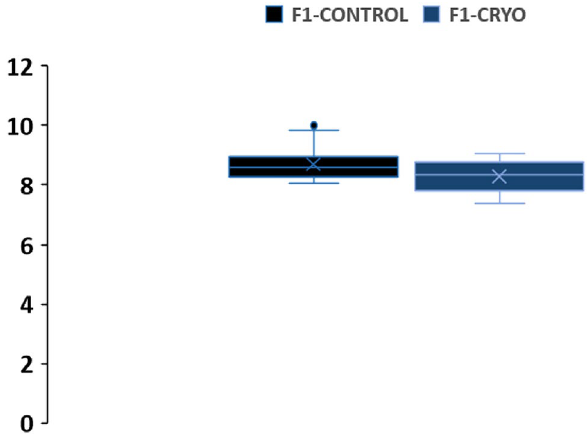
Figure 8. Box plots for the distribution of shell sizes in microns (µm) of F1 adult mussels cultured in traditional culture rafts in a natural environment, in Ria de Vigo (Spain). The line inside the box represents the median value and box ends correspond to upper and lower quartiles. Upper and lower whiskers represent values outside the middle 50% quantile (n = 10). Statistical signification was considered when p <